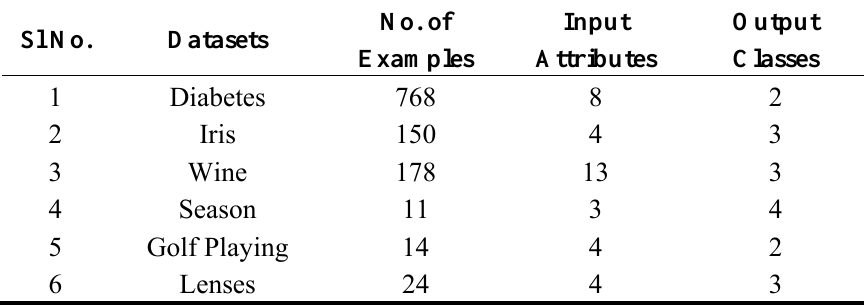
Table 1. Characteristics of